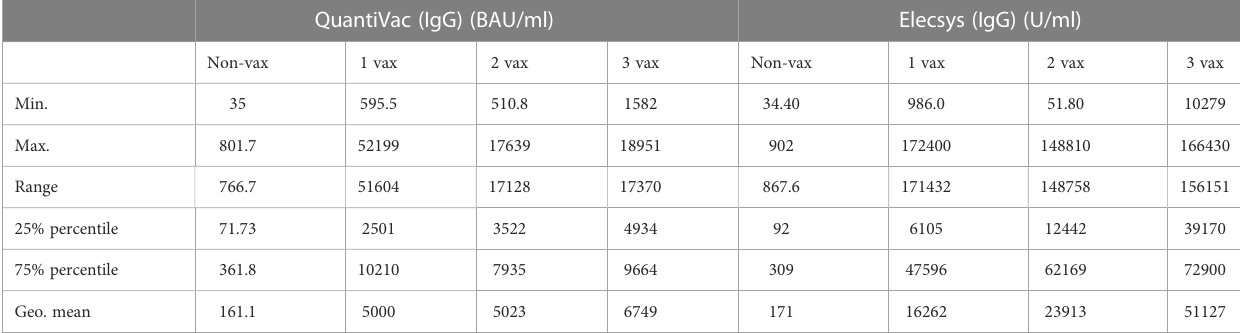
TABLE 2 Comparison IgG titers measured by anti-SARS-CoV-2 Quantivac and Elecsys with number of vaccinations. QuantiVac (IgG)